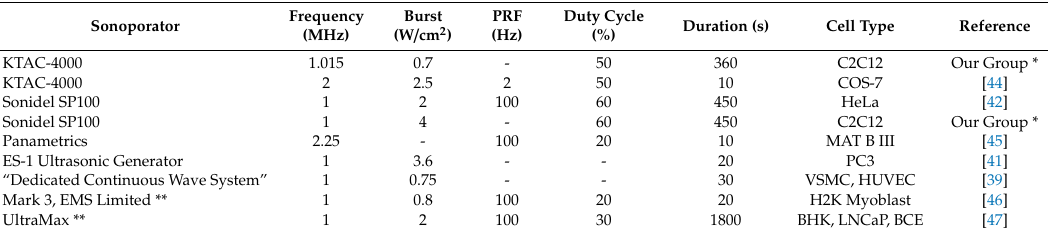
Table 1. Examples of common in vitro sonoporation conditions. Conditions listed are representative of the preferred conditions for pDNA delivery in the referenced experiment, not representative of all conditions tested. PRF = pulse repetition frequency; “-“ = not reported; * = unpublished data; ** = therapeutic